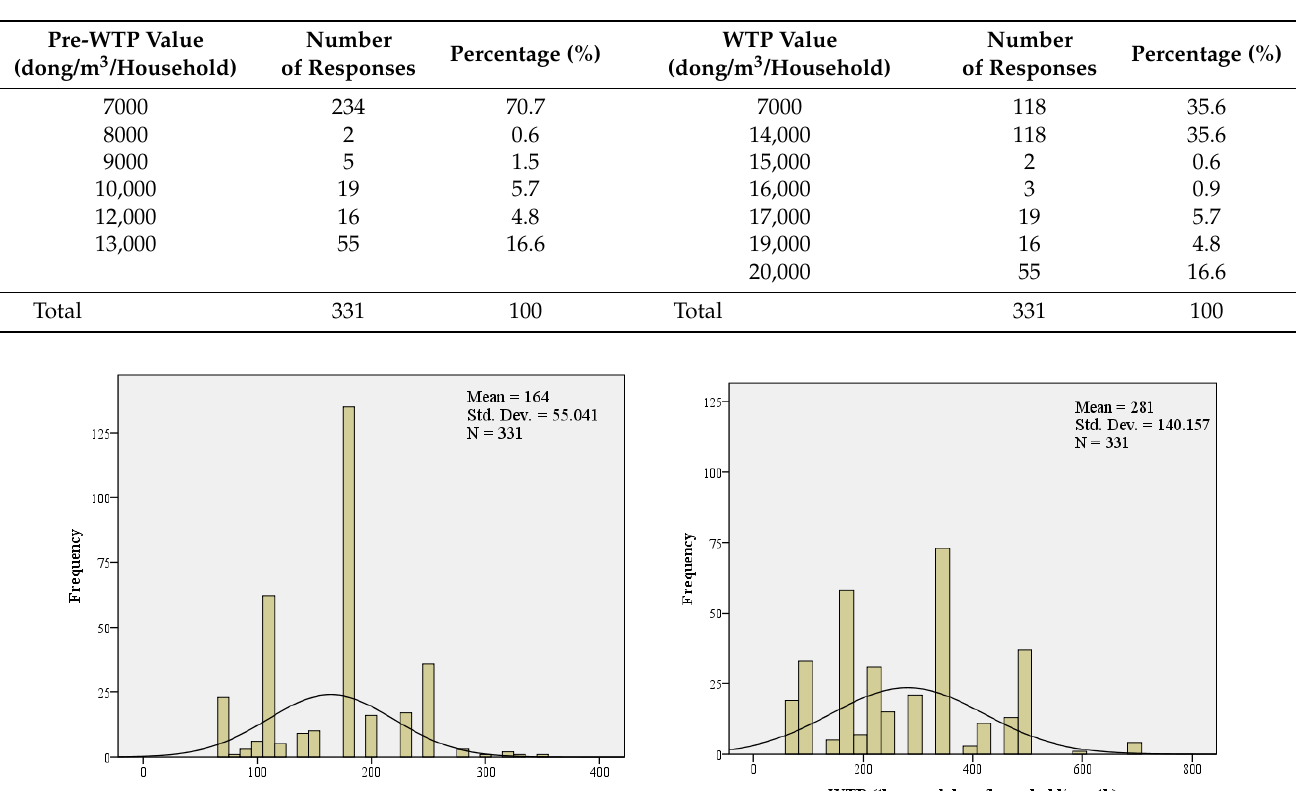
Table 6. Pre-WTP and WTP of the respondents.